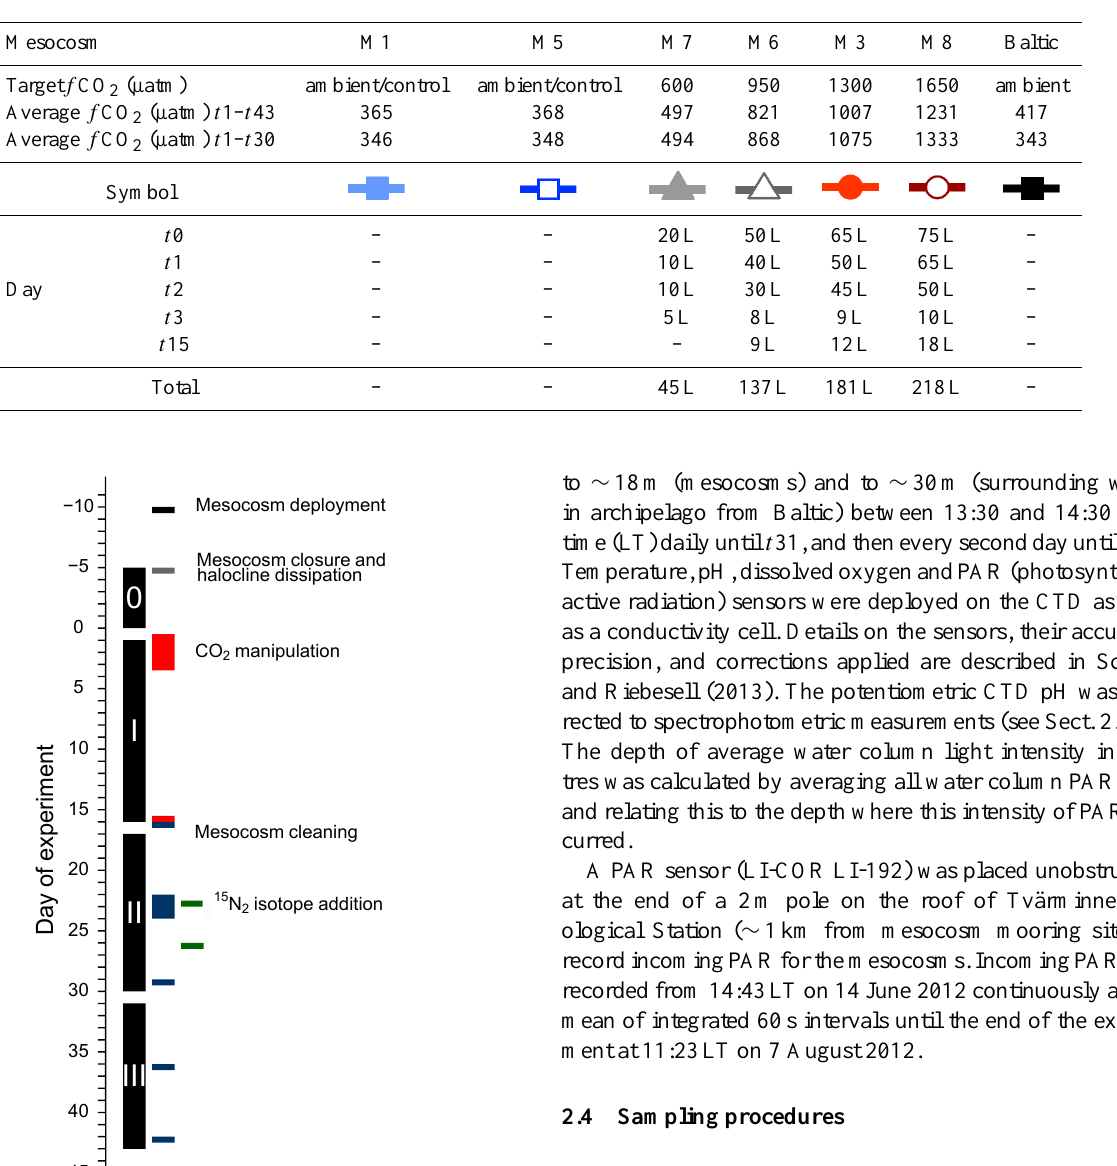
Table 1. Volumes of CO 2 -enriched seawater added for the CO 2 manipulation indicating day of addition and total manipulation volumes.